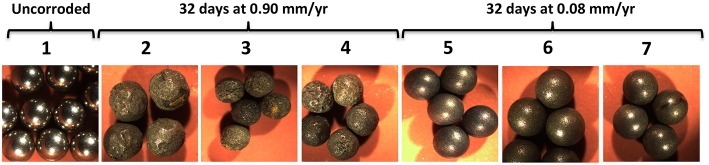
Images of carbon steel beads (Ø = 0.238 cm). Photographs were taken of (1) pretreated beads prior to incubation and following exposure to (2–4) highly and (5–7) moderately corrosive conditions, as indicated.